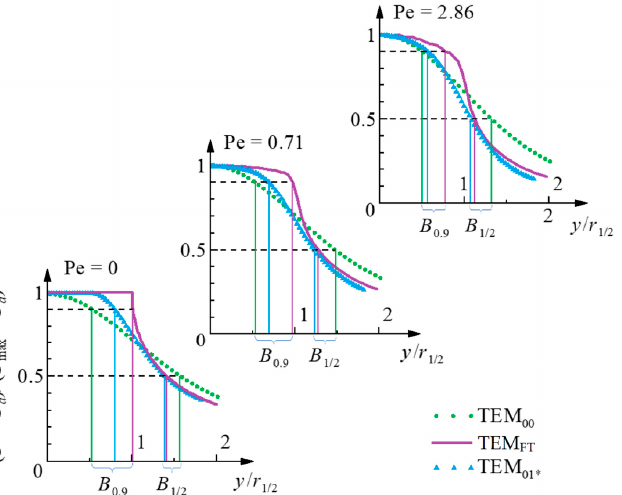
Figure 5. Normalized transverse profiles of the maximum surface temperature and the definition of the widths of laser-treated band ( B 1/2 and B 0.9 ).